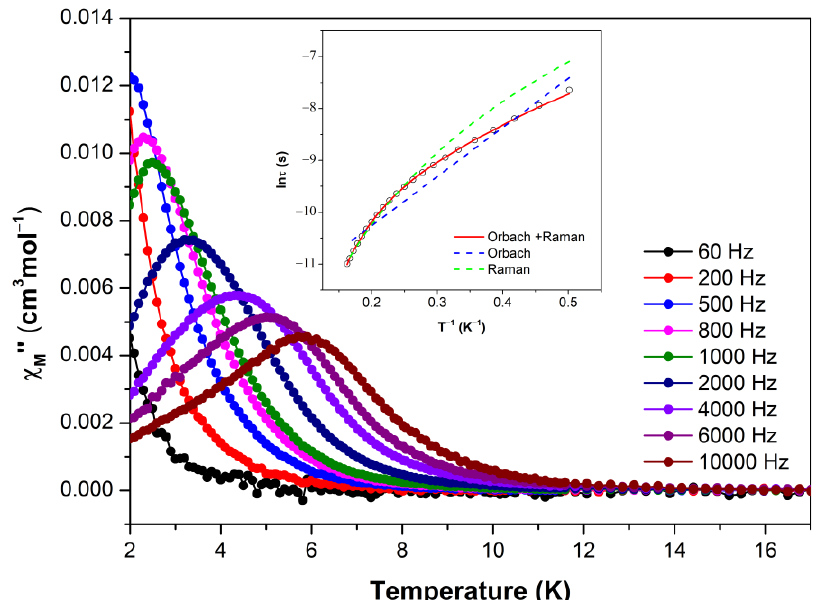
Figure 6. Temperature dependence of out-of-phase components of the ac susceptibility in a dc applied field of 1000 Oe for heterometallic [Co 0.05 Zn 0.95 L] n . Insets: Arrhenius plots. The blue line accounts for the best fit considering Orbach relaxation, the green line refers to Raman relaxation and the red line corresponds to the contribution of Orbach plus Raman relaxation.